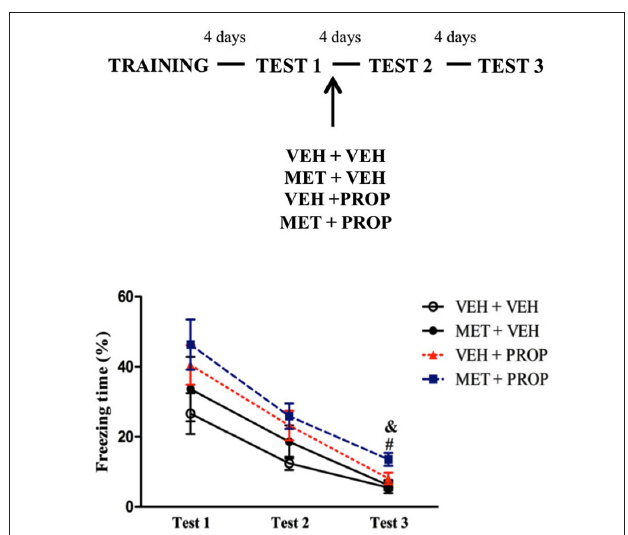
FIGURE 4 | Acute propranolol treatment did not modify the effect induced by acute metyrapone treatment on contextual fear memory . (A) Metyrapone treatment significantly reduced freezing on Test 1 and this effect is not modify by PROP treatment. (B) Metyrapone treatment 90 min before Test 1 reduced freezing behavior on Test 1 and this effect did not persist on subsequent tests.